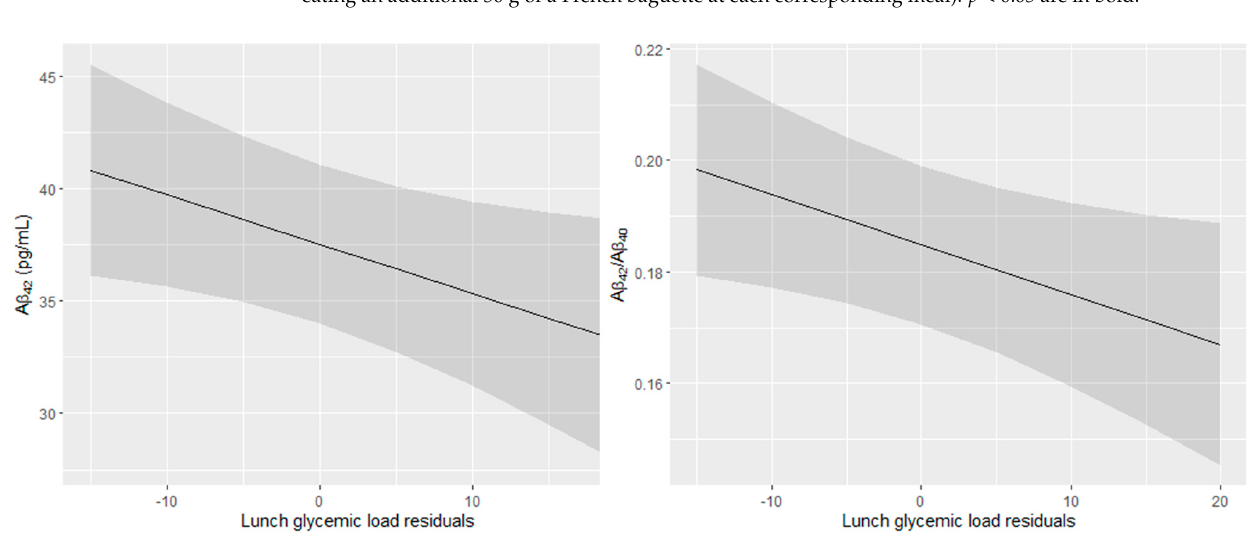
Figure 2. Predicted A β 42 concentration and A β 42 /A β 40 ratio in plasma in function of the lunch glycemic load residuals (95% confidence intervals). All models were adjusted for center, age, sex, education level, APOE4 status, energy intake, serum creatinine, total cholesterol, and Mediterranean- like